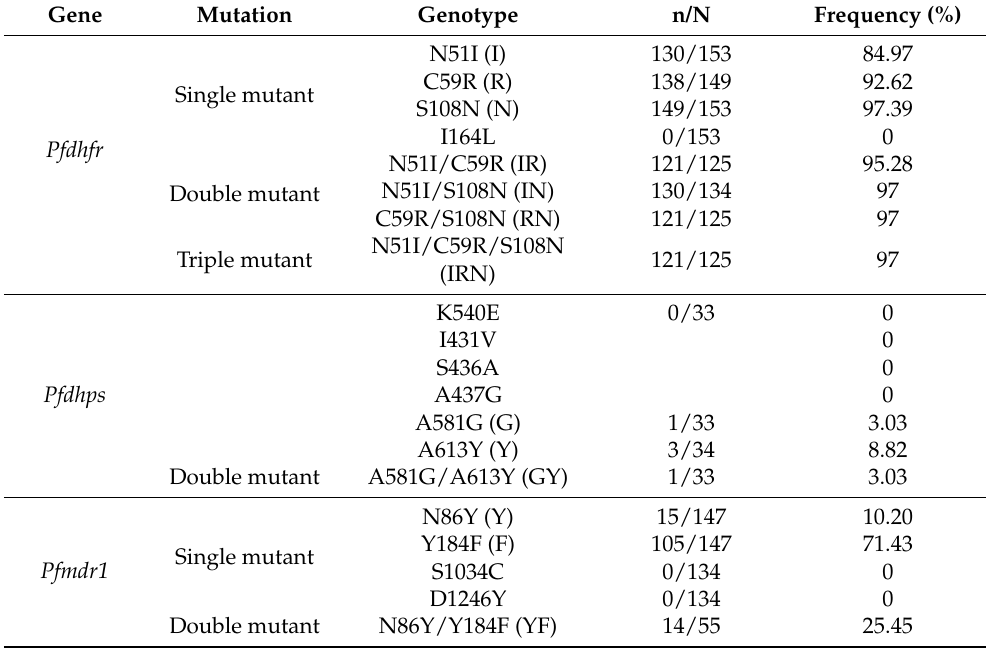
Table 1. Prevalence of mutations in the Pfdhfr , Pfdhps and Pfmdr1